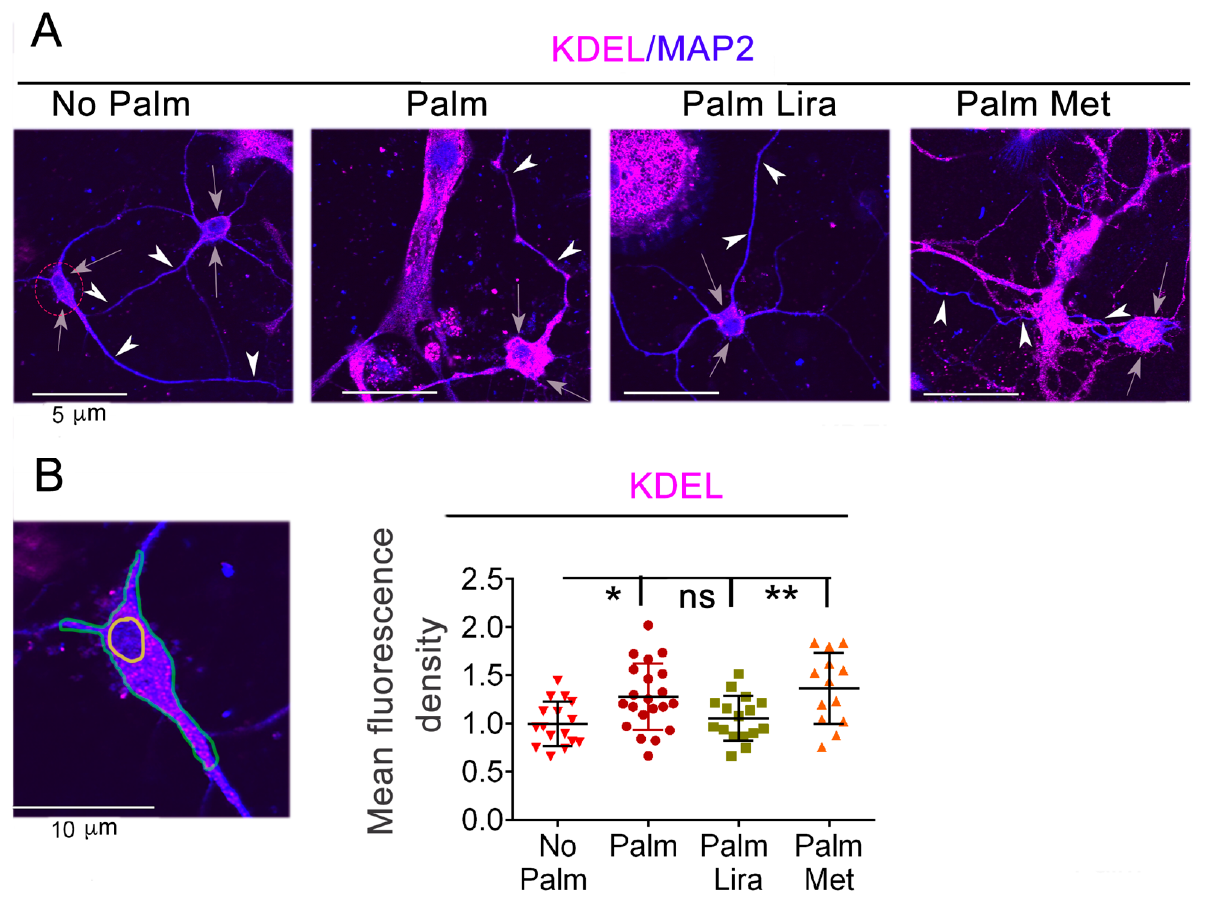
Figure 4. Exposure to palmitate disrupts ER protein homeostasis in hypothalamic neurons. Liraglutide, but not metformin, normalizes ER proteostasis. ( A ) Neurons in primary culture were incubated for 48 h with and without 250 µM palmitate and with and without addition of 100 nM liraglutide (Lira) and 2 mM metformin (Met) to the medium. Cells were fixed, immunostained with anti-MAP2 (blue fluorescence) and anti-KDEL (magenta fluorescence) antibodies, and imaged by confocal fluo- rescence. Grey arrows indicate cell bodies. White arrowheads indicate neuronal processes. ( B ) Mean fluorescence pixel density of KDEL in a ROI that includes the cytoplasm of the neuron cell body